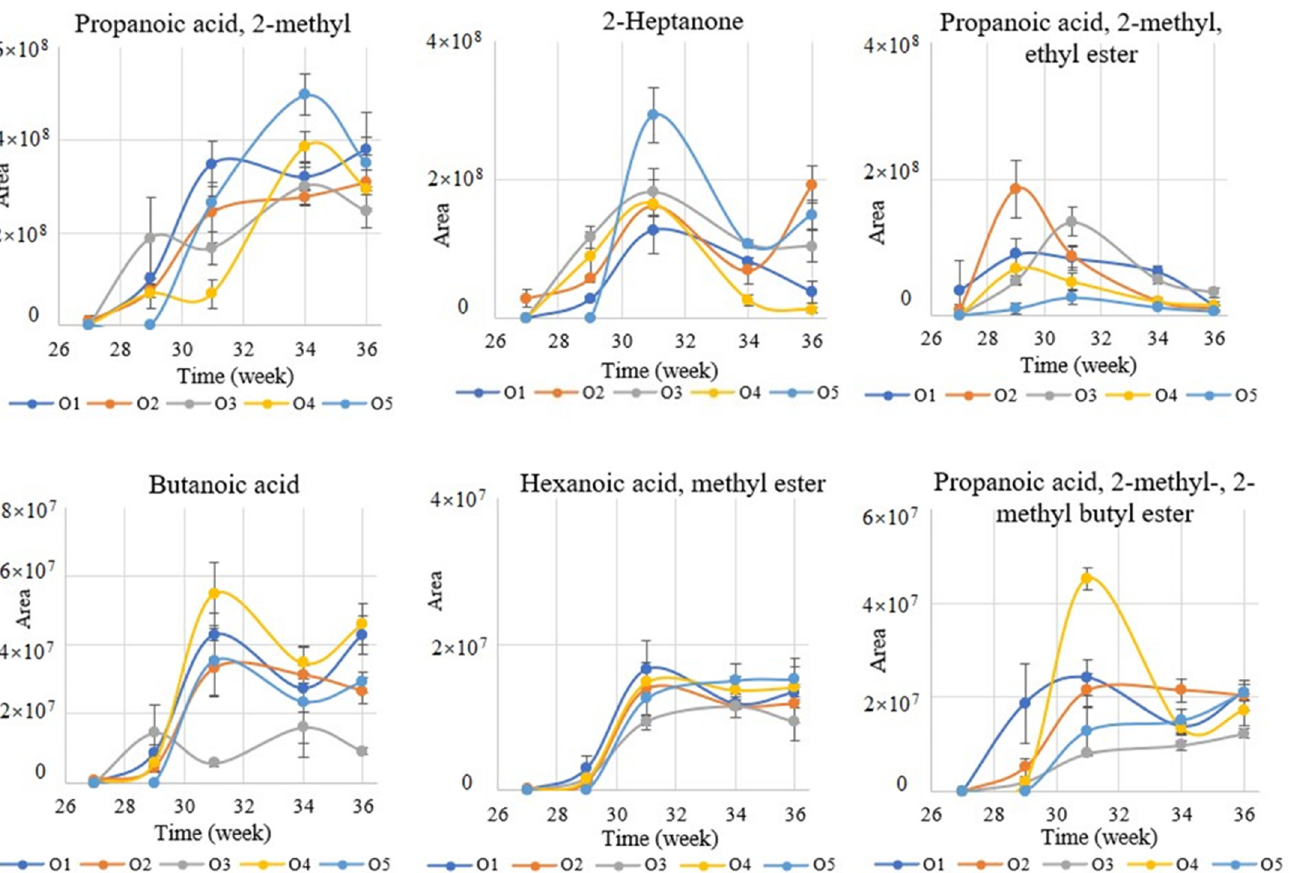
Figure 2. The effect of carob maturation of propanoic acid, 2-methyl- (sour/cheesy odor), 2-heptanone (fruity/spicy odor), propanoic acid, 2-methyl-, ethyl ester- (fruity/sweet odor), butanoic acid (cheesy/buttery odor), hexanoic acid methyl ester (fruity/pineapple odor), and propanoic acid, 2-methyl-, 2-methylbutyl ester for each week of the examined period. ψ -axis (area) corresponds to AUC.